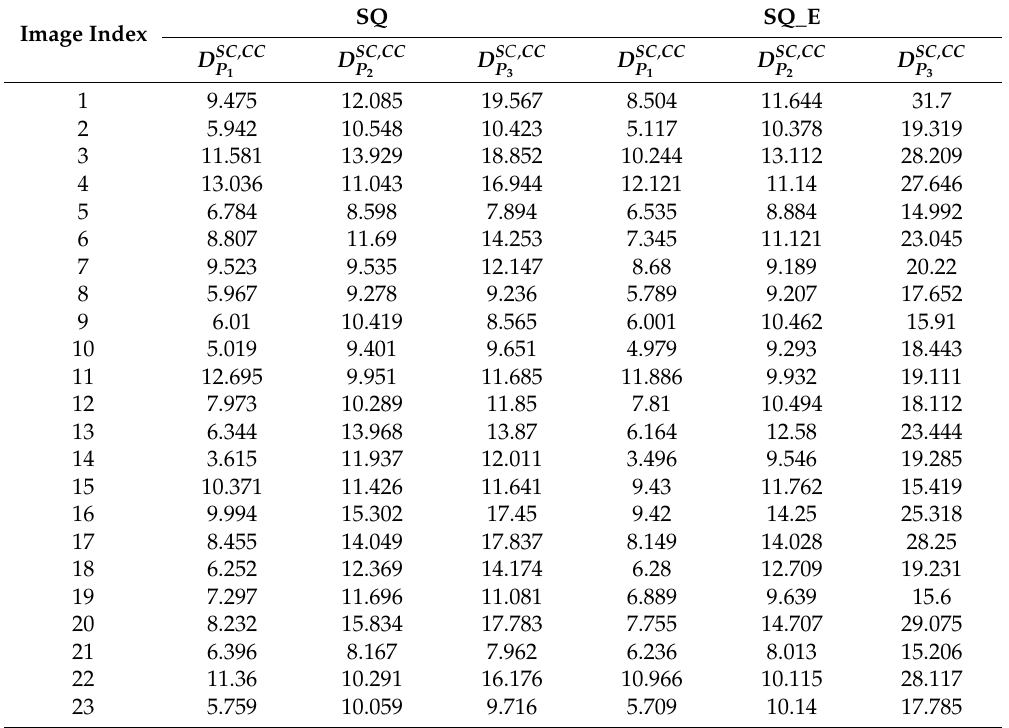
Table 4. The dissimilarity measurement of D Hessian